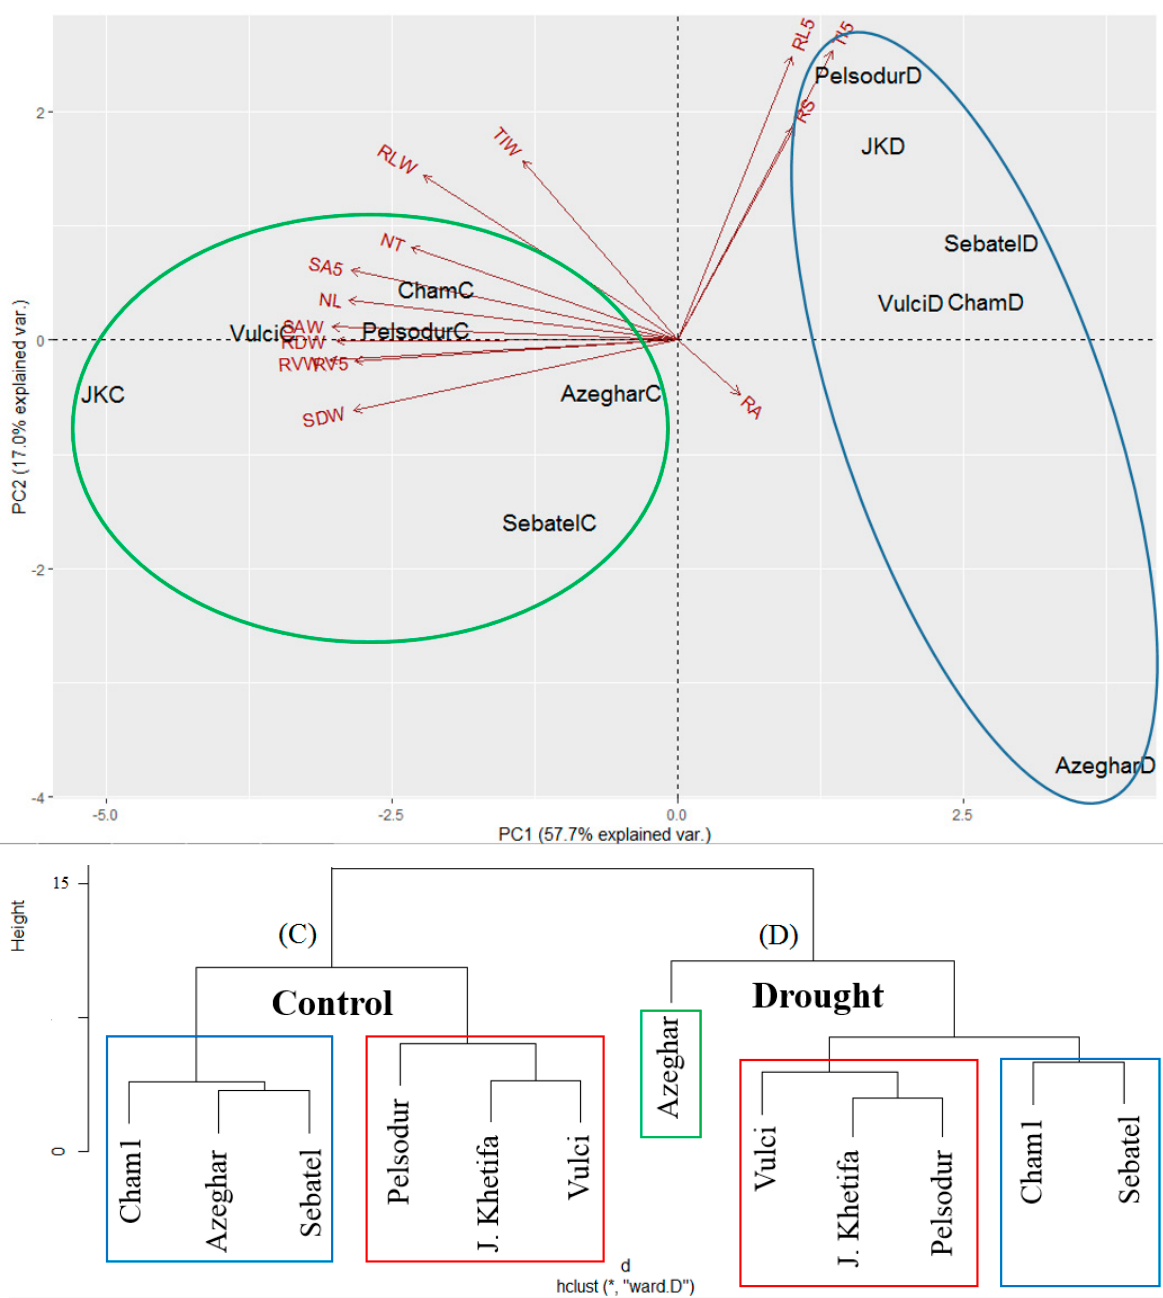
Figure 9. Principal component analysis and cluster dendrogram of 6 investigated durum wheat genotypes under control (C) and drought (D) conditions. NL—number of leaves; NT—number of tillers; SDW—shoot dry weight; RVW—total root volume; RLW—sum of all root lengths; TIW—total number of tips; RDW—root dry weight; SAW—total root surface area; RS—root shoot ratio; RL5—sum of root lengths in the first 5 cm below the ground; SA5—root surface area in the first 5 cm below the ground; TI5—number of tips in the first 5 cm below the ground; RV5—root volume in the first 5 cm below the ground; RA—root angle of plants grown in greenhouse under drought conditions; RAF—root angle of plants grown in the field. * indicates significance at p < 0.05